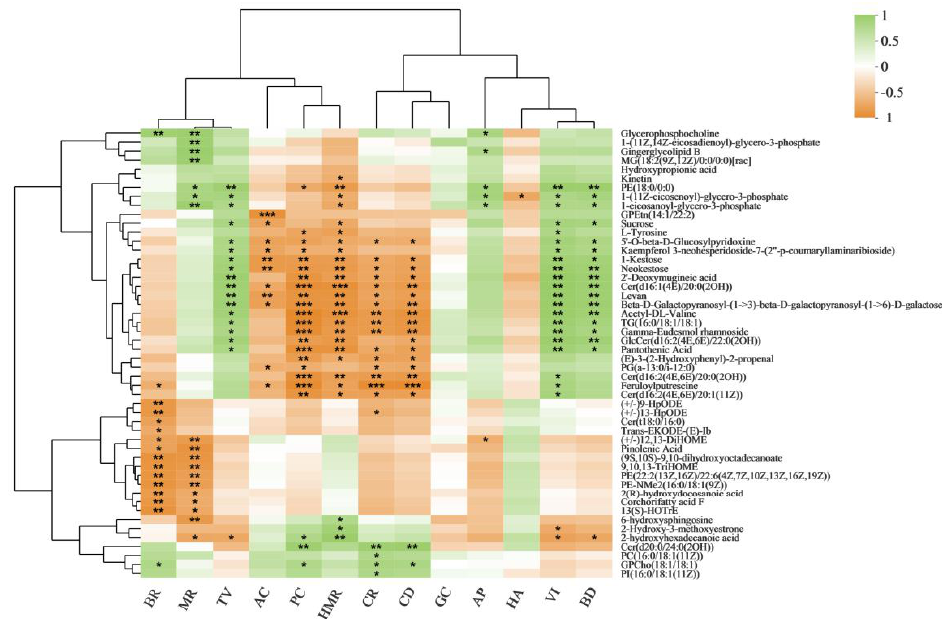
Figure 3 . Correlation analysis of rice quality traits and DMs. * p < 0.05, ** p < 0.01, *** p < 0.01.